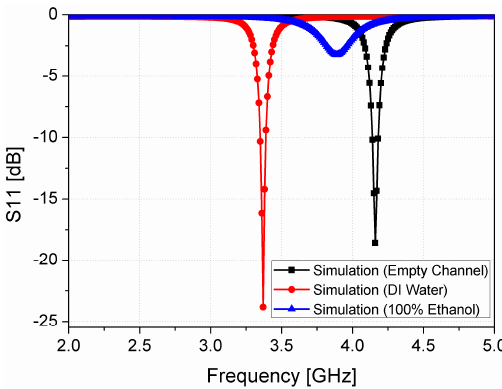
Figure 6. Simulated S-parameters of the proposed CSRR-loaded patch using empty channel (air), DI water, and 100%